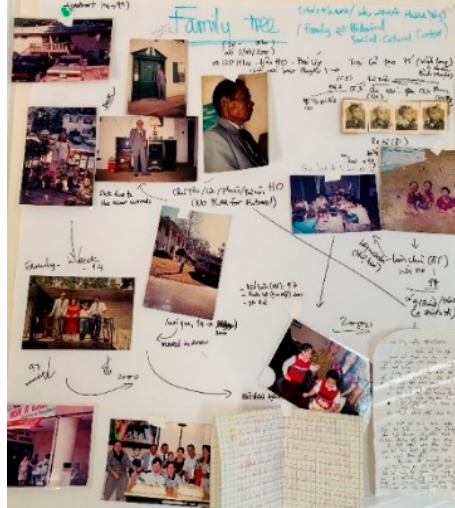
Figure 1. It was a roller coaster of emotions and feelings for both of us in different ways. There were a lot of pauses and silences hidden in this family tree.